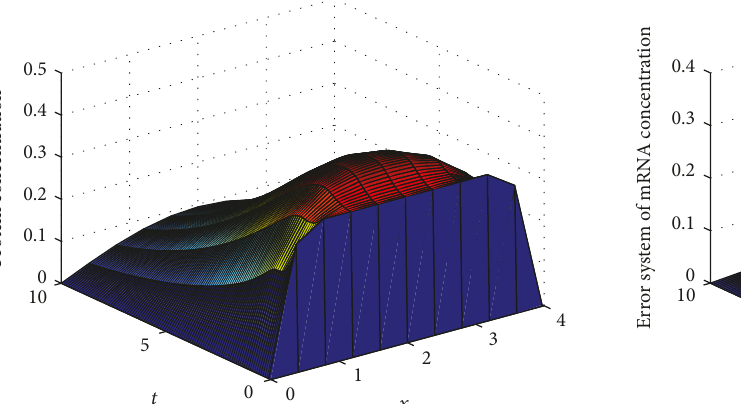
Figure 2: The real trajectories of protein concentration ( p t , x